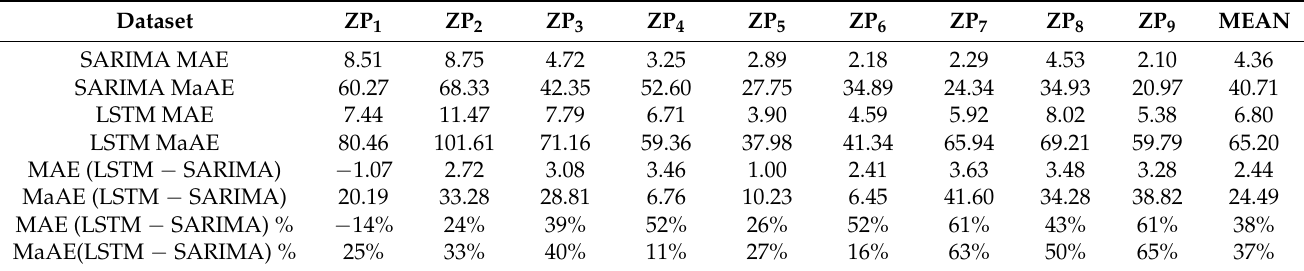
Table 6. Comparison of algorithm simulation results for datasets ZP 1 . . . , ZP 9 .